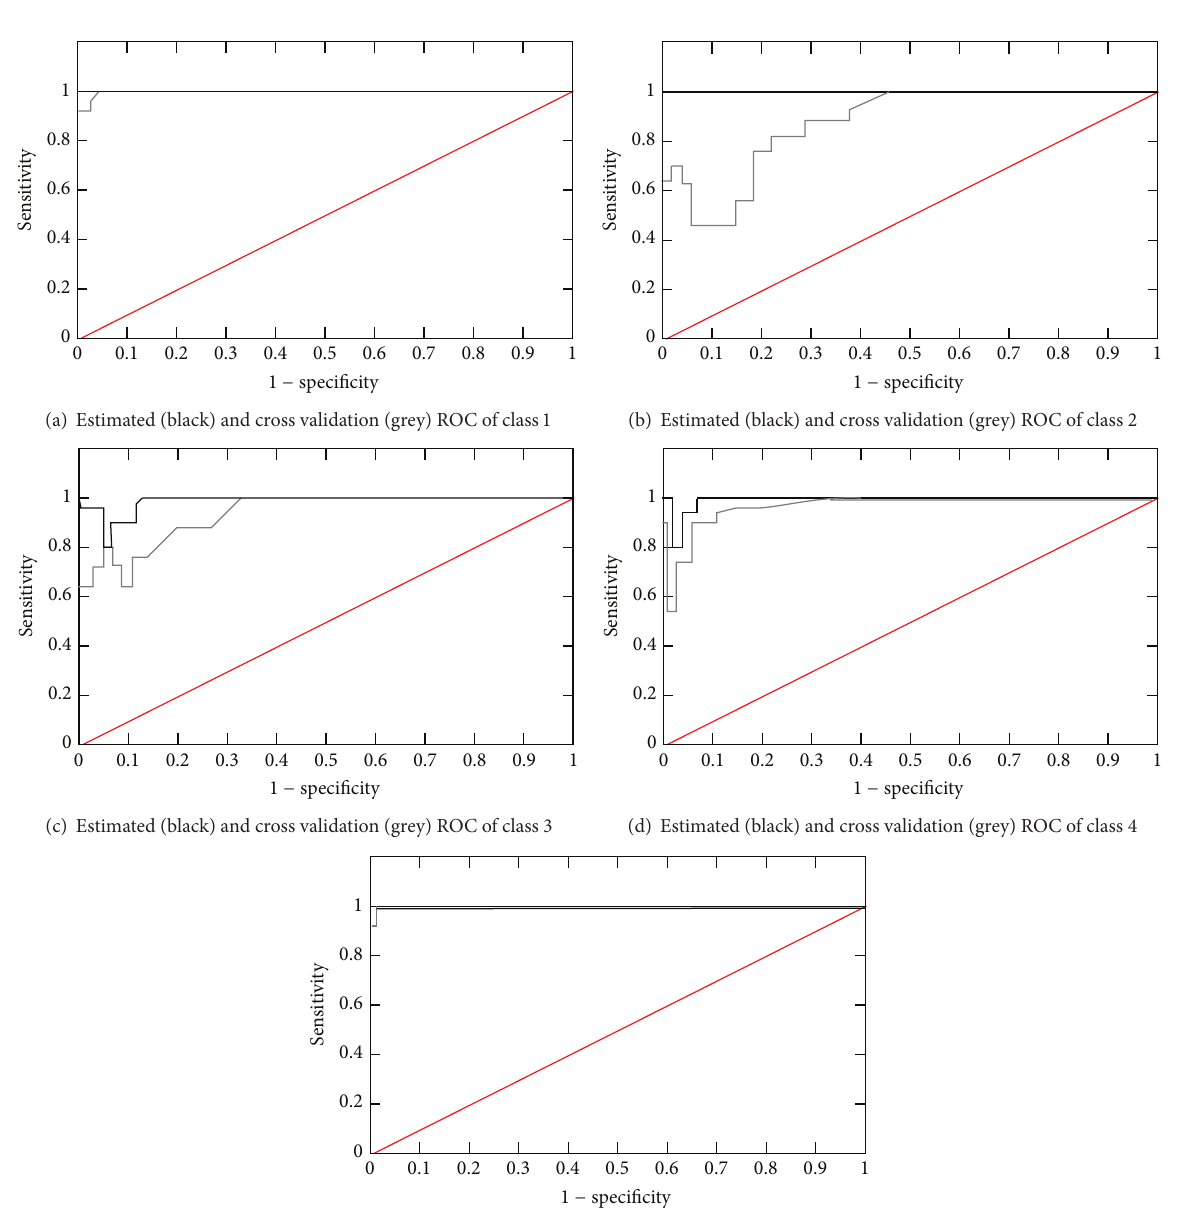
values ( 𝑐 changed with fixed constant 𝑔 ) and their ROC curves of the second predictive model to predict the five different classes are displayed in Figure